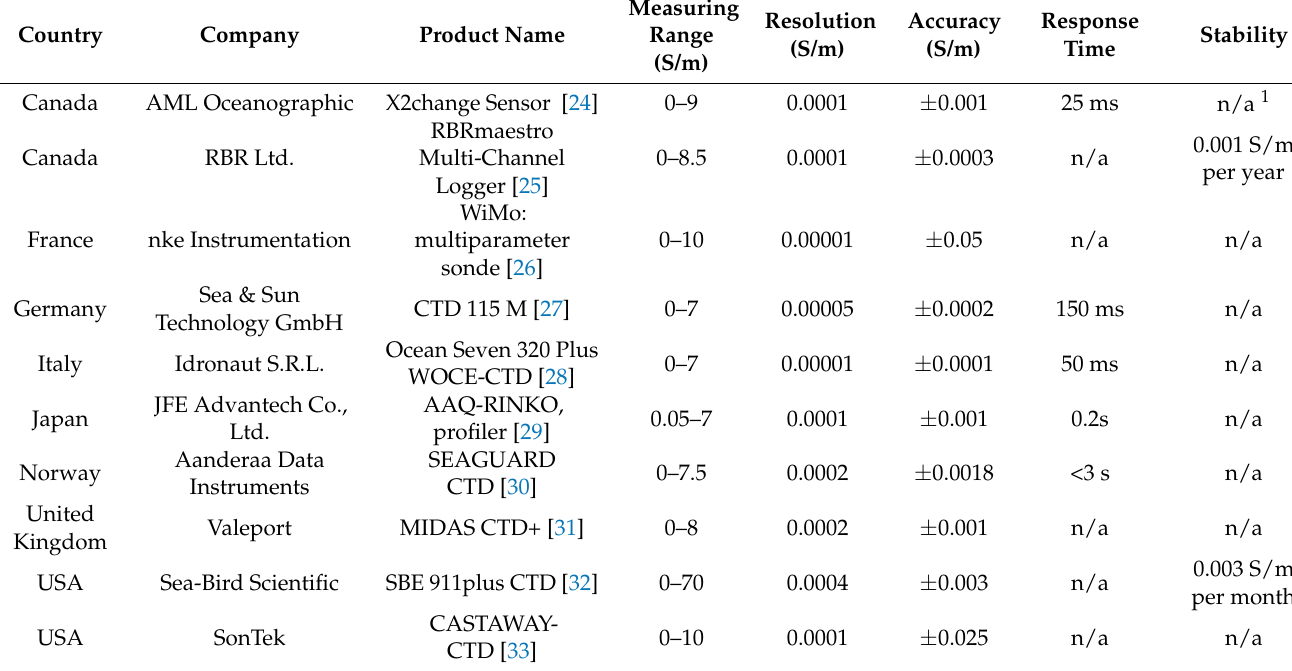
Table 2. The performance of commercial CTD